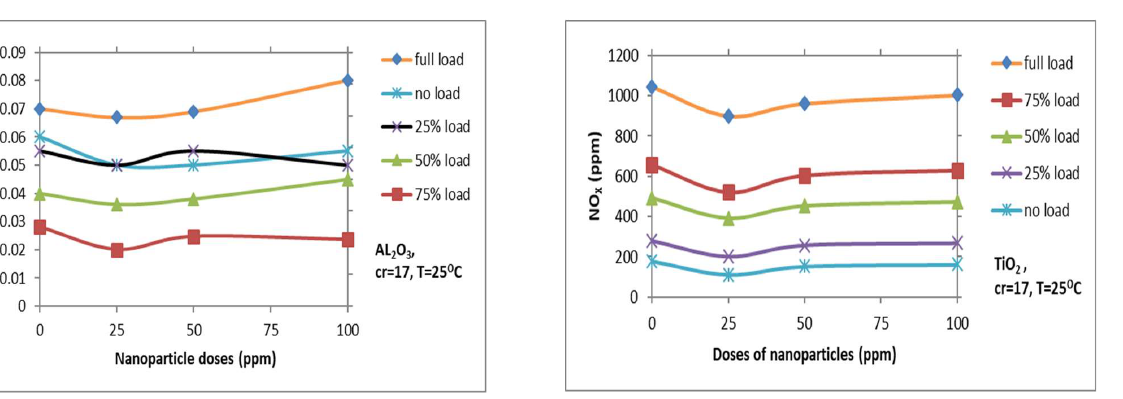
Fig. 6. Variation of Nitrogen Oxide Emissions (NOx) with Titanium nanoparticles doses.